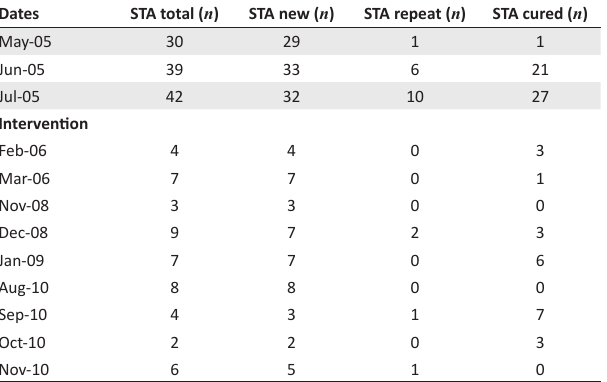
TABLE 4: Monitoring udder health results ( Staphylococcus aureus ) on one of the 20 herds over time.